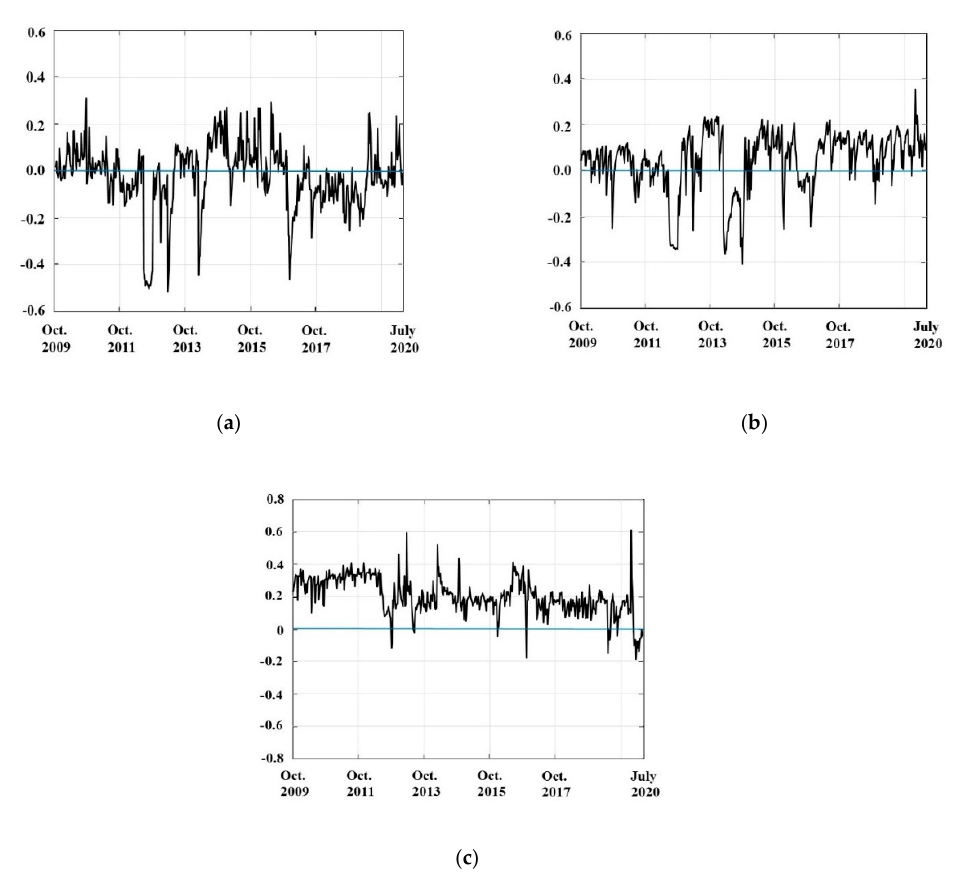
Figure 2. Time-varying correlations between two volatilities. Note: The correlations between two conditional variances are calculated from the estimates of the VAR(1)-GARCH(1,1)-BEKK model with the sudden changes: ( a ) the EUA-biofuel; ( b ) the EUA-Brent oil; ( c ) biofuel-Brent oil.